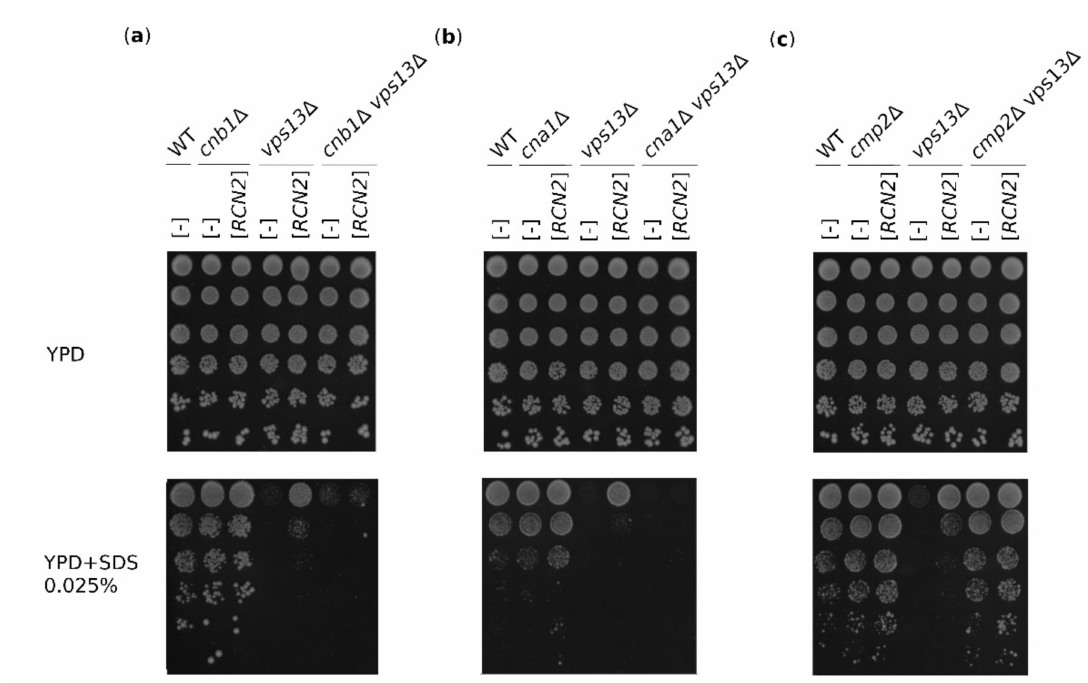
Figure 3. The suppression of vps13 ∆ mutant SDS hypersensitivity by RCN2 requires active calcineurin. The growth of wild-type and cnb1 ∆ , vps13 ∆ , and cnb1 ∆ vps13 ∆ mutants ( a ), wild-type, cna1 ∆ , vps13 ∆ , and cna1 ∆ vps13 ∆ ( b ), and wild-type, cmp2 ∆ , vps13 ∆ , and cmp21 ∆ vps13 ∆ mutants ( c ) transformed with empty vector [-] or vector bearing the RCN2 gene on YPD and YPD + SDS medium. Plates were incubated for 3